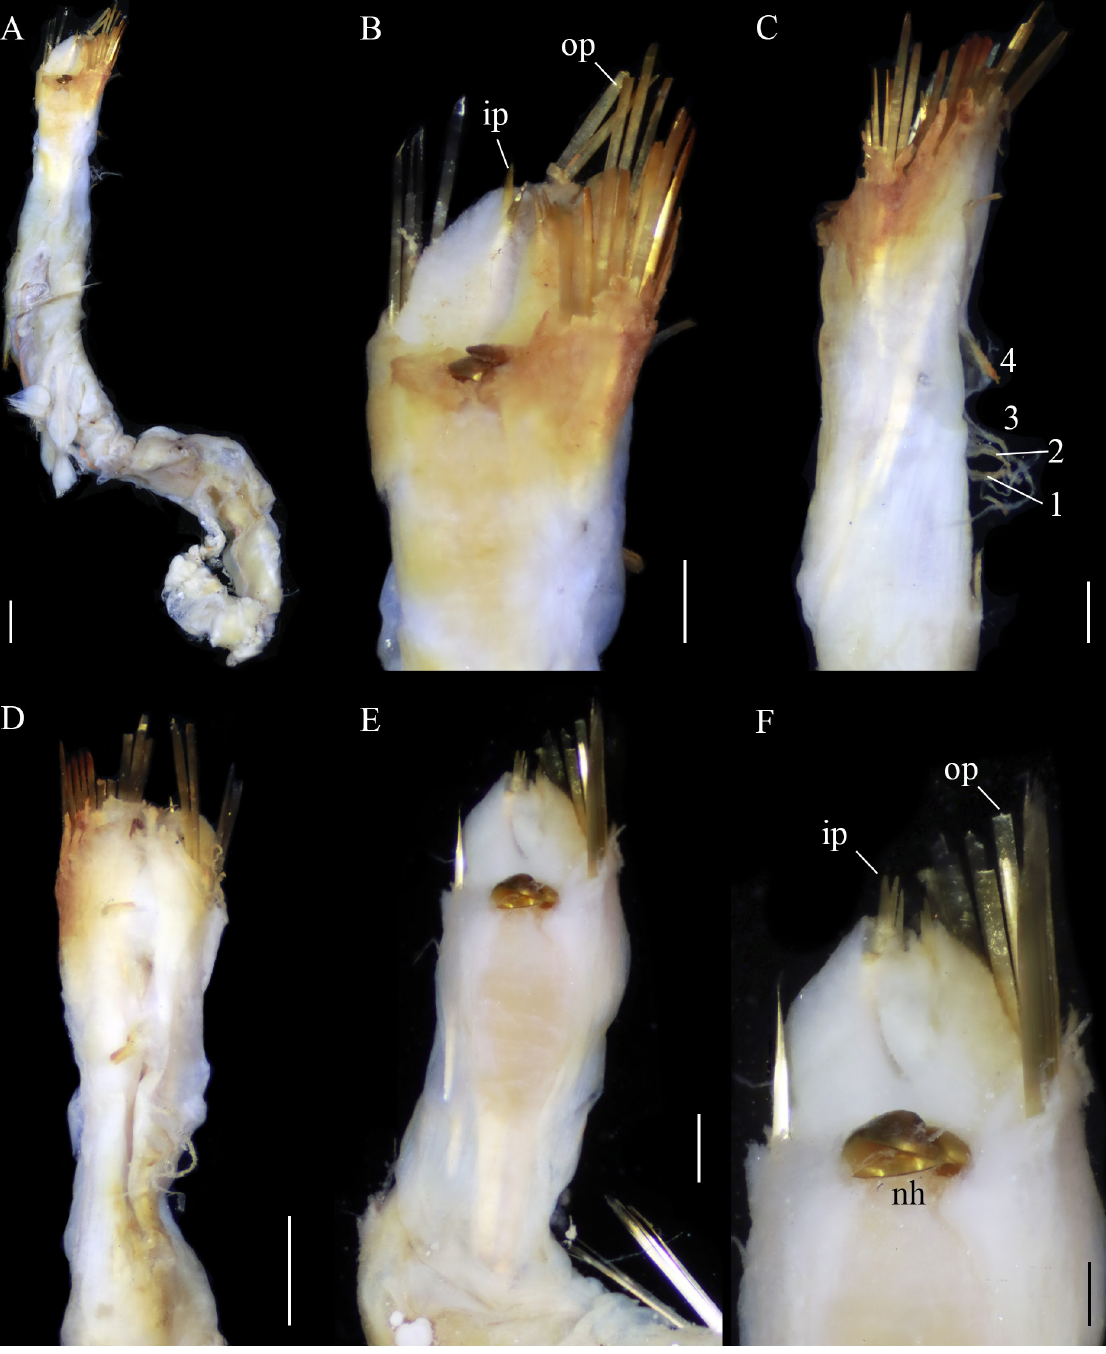
Fig. 18. Tetreres israeli sp. nov., holotype (UMML-22.1195). A . Complete specimen, dorsal view. B . Anterior region, dorsal view. C . Anterior region, lateral right view. D . Anterior region, ventral view. E . Paratype (UMML-22.1196). F . Operculum of the paratype. Abbreviations: ip = inner paleae; nh = nuchal hooks; op = outer paleae. Numbers indicate the tentacular filaments. Scale bars: A, C–E = 2 mm; B = 1 mm; F = 0.5